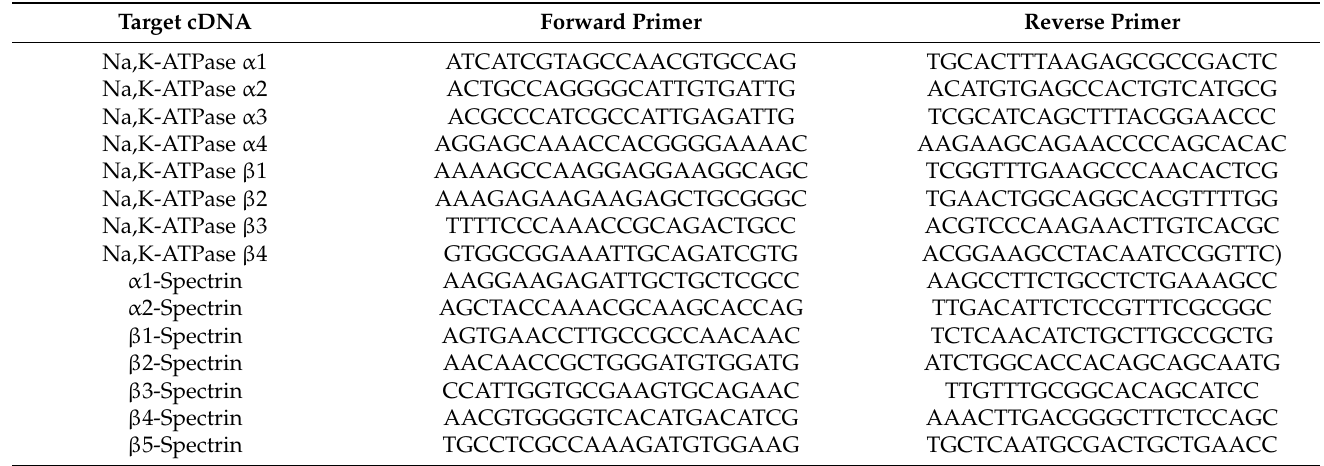
Table 6. Primers used for RT-PCR with cDNA from FACS purified CPECs (all 5 (cid:48) -3 (cid:48)